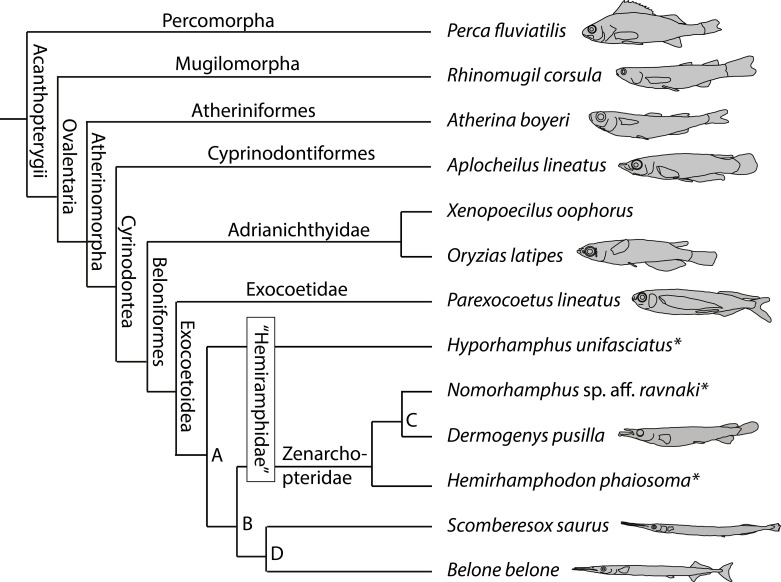
Phylogenetic framework.Arrangement of the species studied herein and those from the literature (*) used for the reconstruction of character evolution (character mapping); following Lovejoy, Iranpour & Collette (2004; compare to Fig. 1C). Outlines indicate the species, which were manually dissected herein; not to scale (compare to Figs. 5–20).